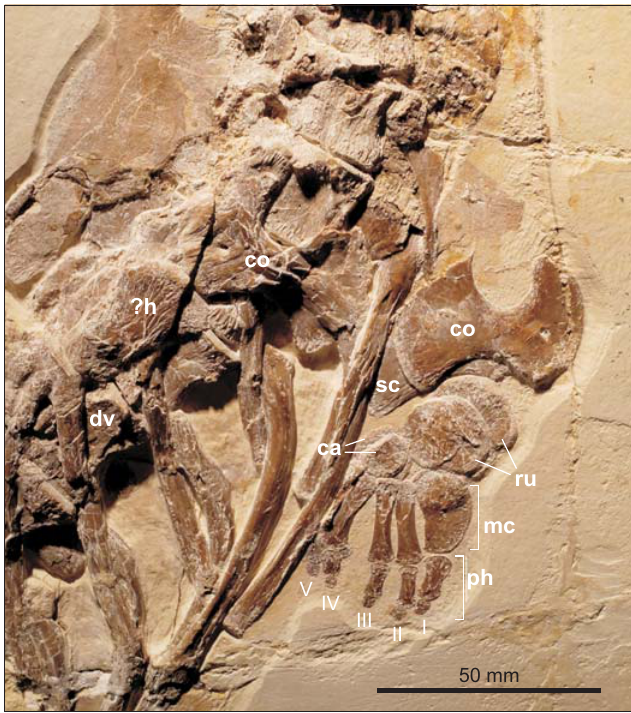
Fig. 5. Metriorhynchid thalattosuchian Cricosaurus bambergensis sp. nov. (NKMB-P-Watt14/274) holotype, late Kimmeridgian of Wattendorf (south- ern Germany). Pectoral girdle and forelimb elements. Abbreviations: ca, carpal elements; co, coracoid; cv, cervical vertebra; dv, dorsal vertebra; ?h, questionable humerus; mc, metacarpal elements; ph, phalanges; ru, ra- dius and ulna; sc,